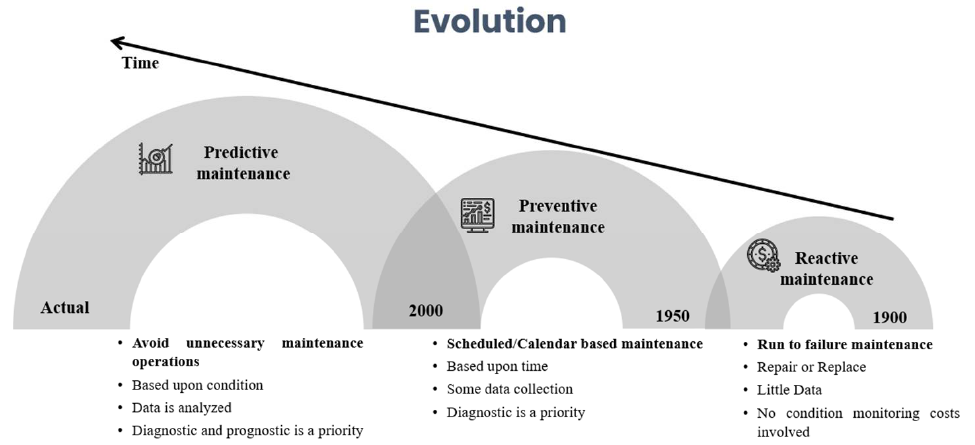
Figure 3. Evolution of maintenance activities and methods.